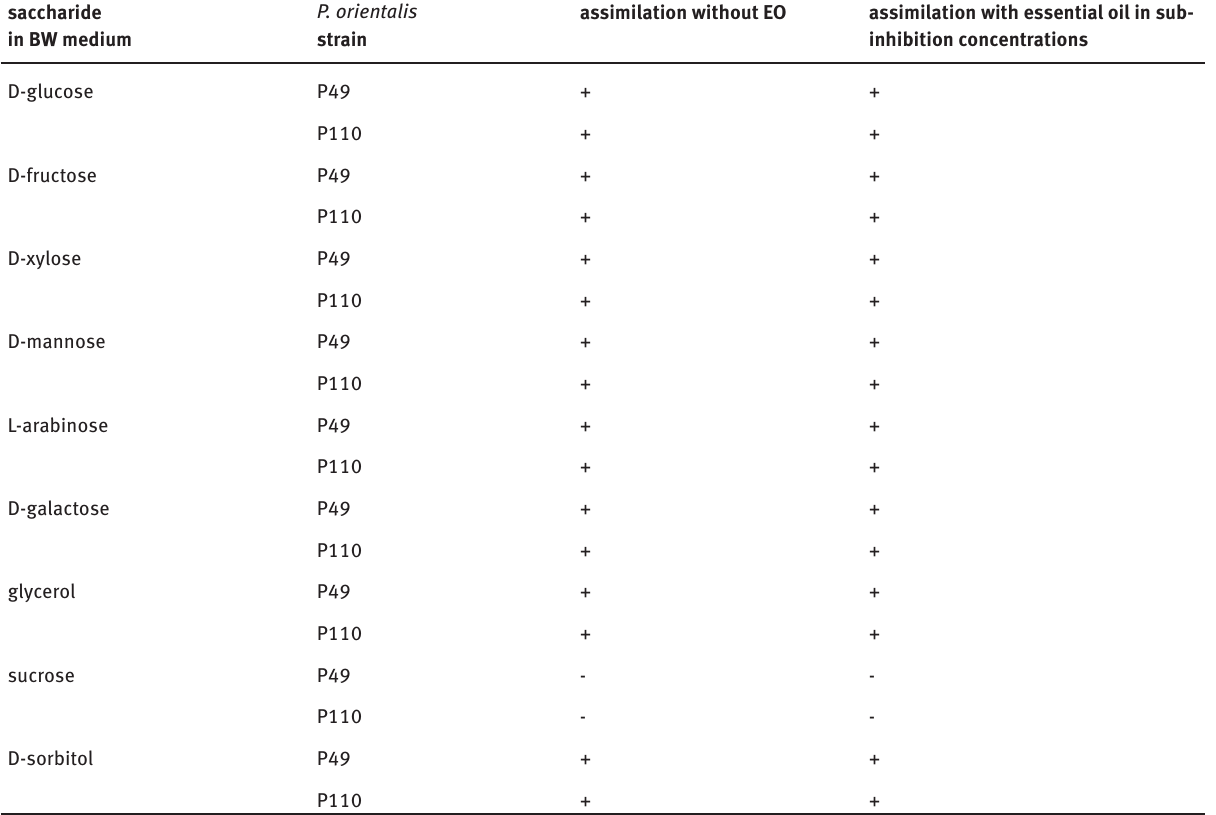
Table 4: The ability of assimilation of selected saccharides by P. orientalis strains in normal cultivation and under the influence of investigated EOs in sub-inhibition